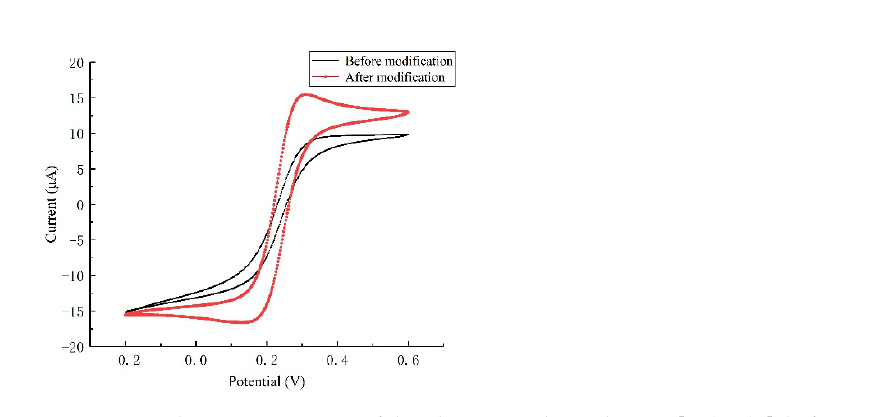
Figure 6. CV characteristic curve of the ultramicro electrode in K 3 [Fe(CN) 6 ], before and after modification.